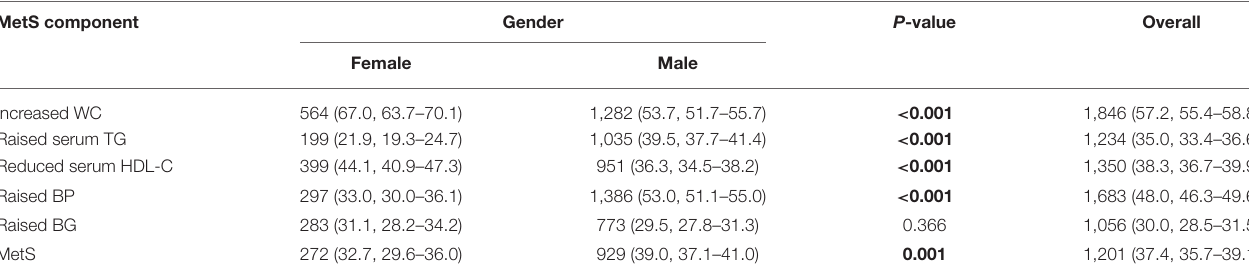
TABLE 1 | Overall prevalence of the MetS and its five components in the study population stratified by gender, n (%, 95% confidence interval).